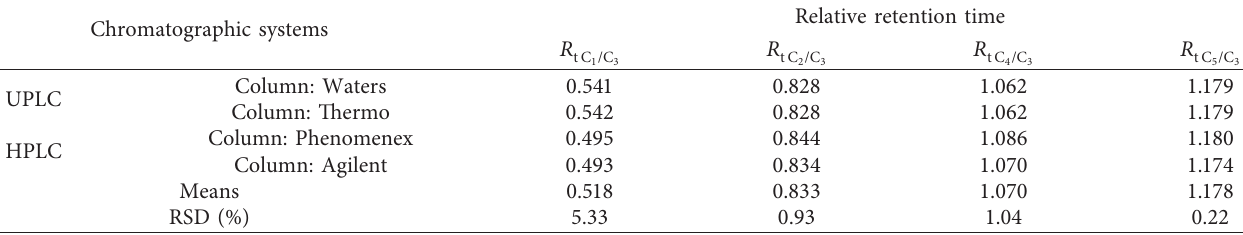
Table 4: Relative retention time of 5 constituents.